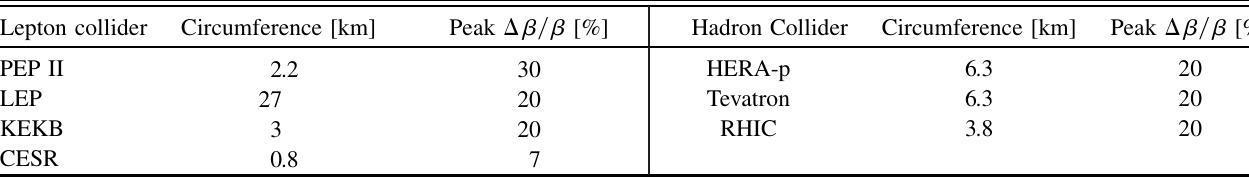
TABLE I. Peak (cid:1) beating of various high energy colliders as collected during the Optics Measurements, Corrections and Modeling for High-Performance Storage Rings workshop [1].